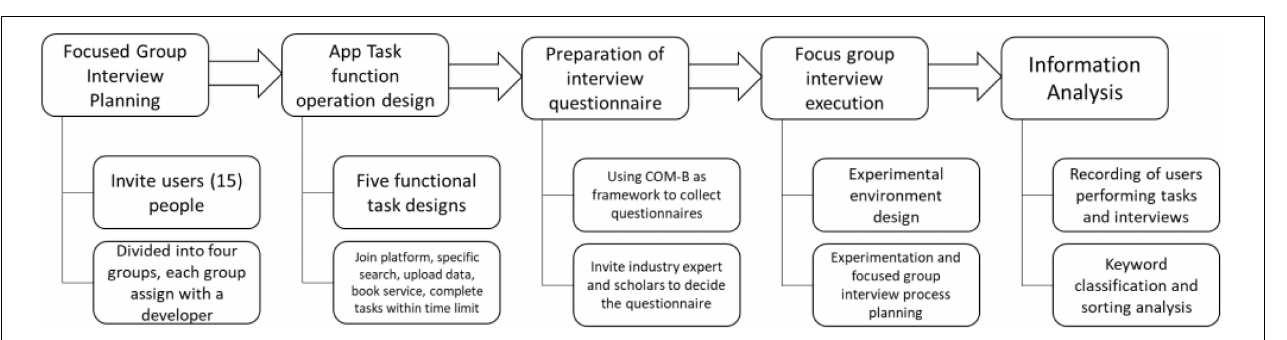
FIGURE 3 | Research